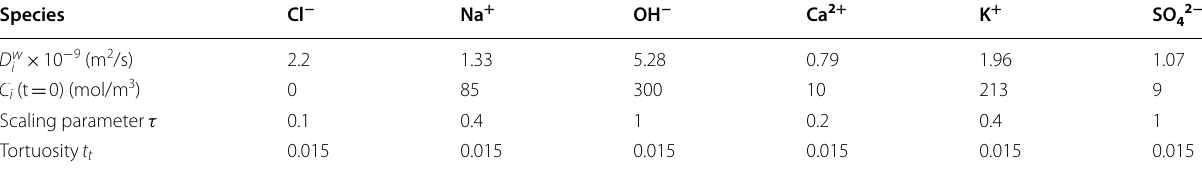
Table 1 Pore solution and pore system characteristics (Johannesson et al. 2007). Species Cl − Na + OH − SO 42 − D w i 10 − 9 (m 2 /s) × C i (t 0) (mol/m 3 ) = Scaling parameter τ Tortuosity t t